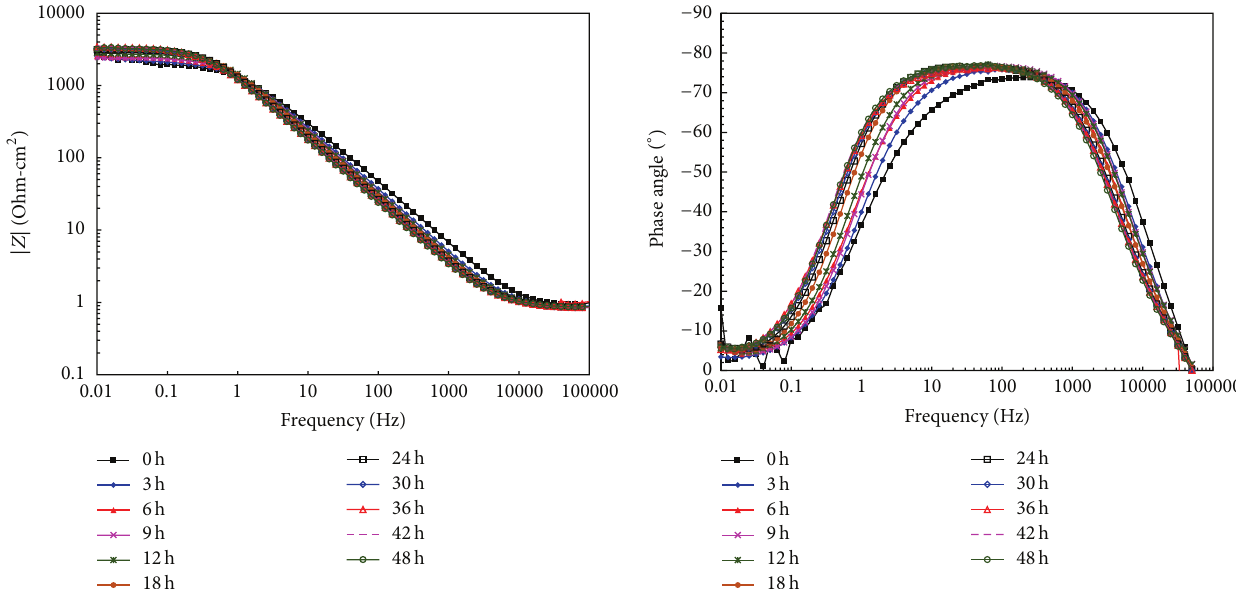
Figure 9: Bode plots for Ni 3 Al-1Cu in 1.0 M H 2 SO 4 solution at 25 ∘ C.